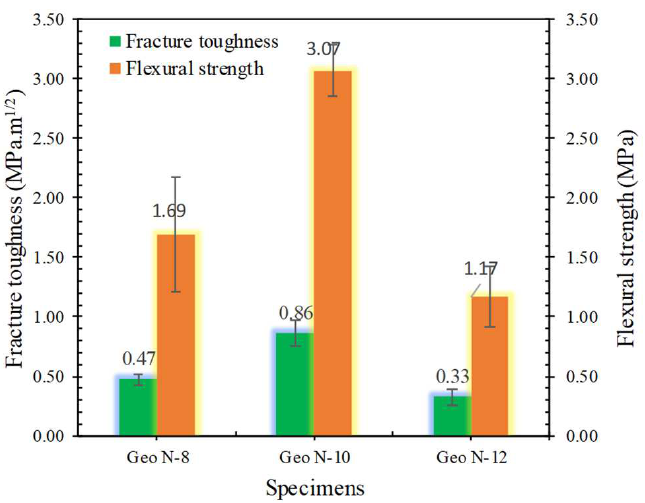
Figure 8. Fracture toughness and flexural strength of geopolymer paste made of various molarities .